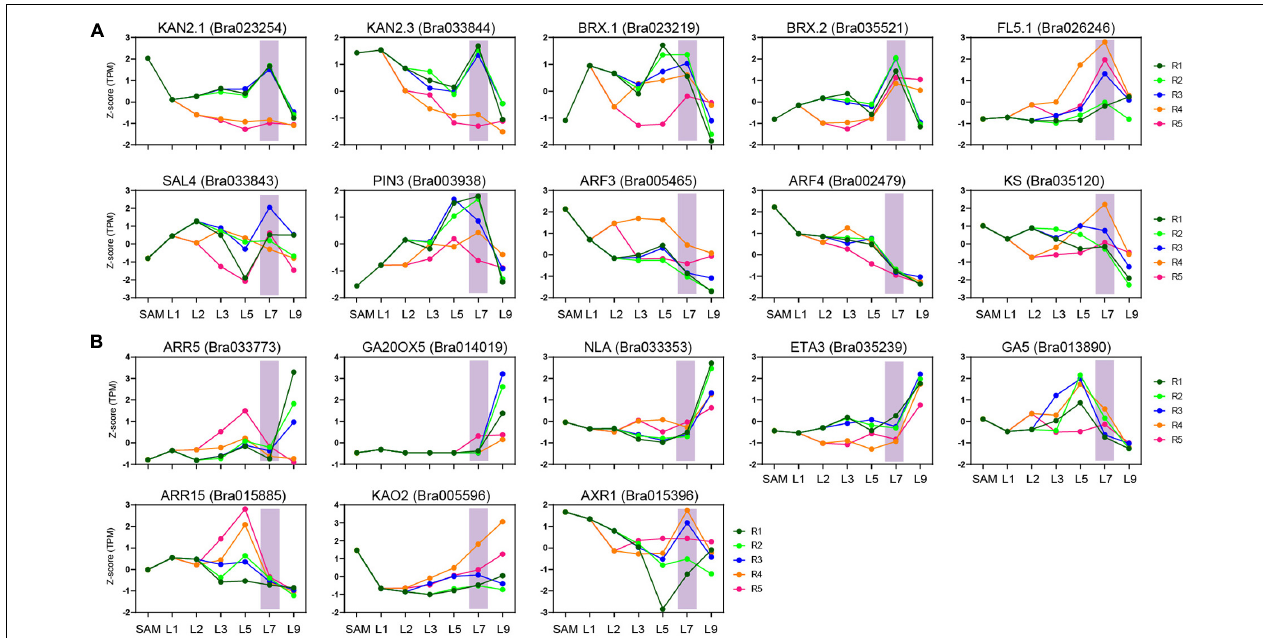
FIGURE 6 | Expression characteristics of heading candidate genes. (A) The expression characteristics of reported heading candidate genes in key transition leaves. (B) The expression characteristics of heading candidate genes newly identified by domesticated selection analysis.